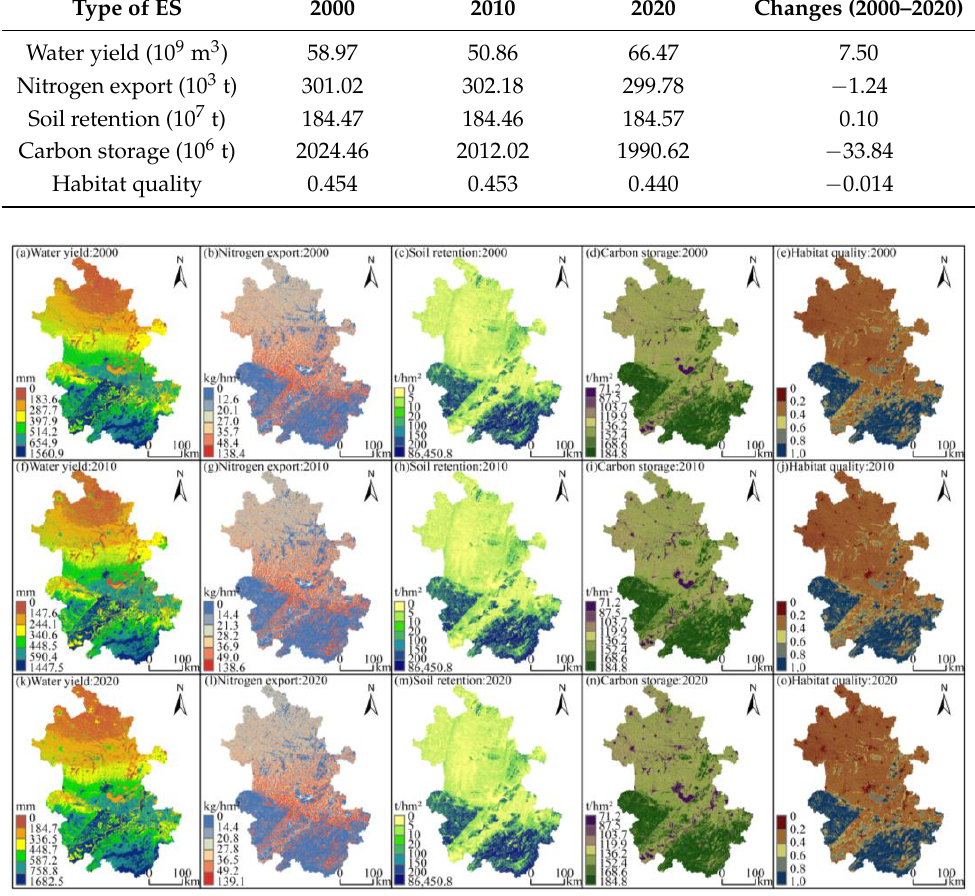
Figure 5. Spatiotemporal distribution of ESs in Anhui Province from 2000 to 2020.